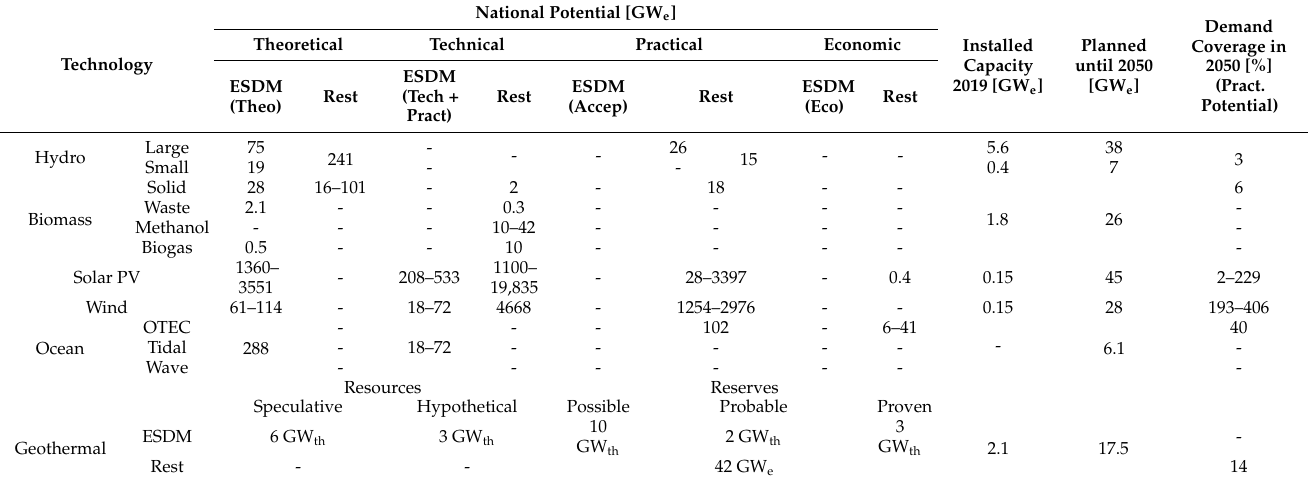
Table 6. Potential of RET in Indonesia. For references, see respective sections.